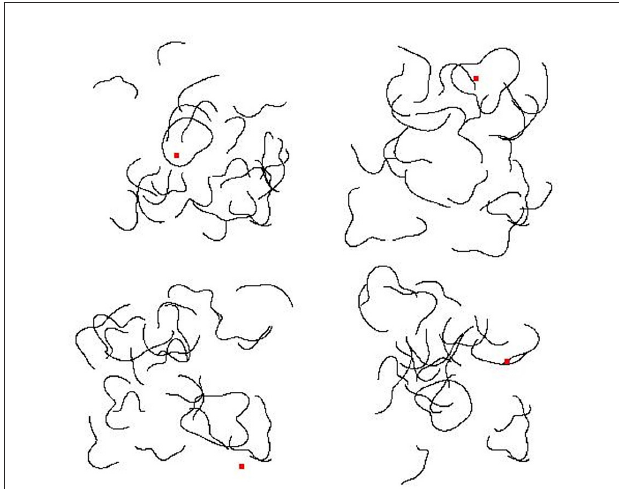
FIGURE4 Example training images for Experiment 2a. (Top) Two “Inside” images. (Bottom) Two “Outside” images. Category membership was determined by the position of the small red square, either inside or outside of a closed